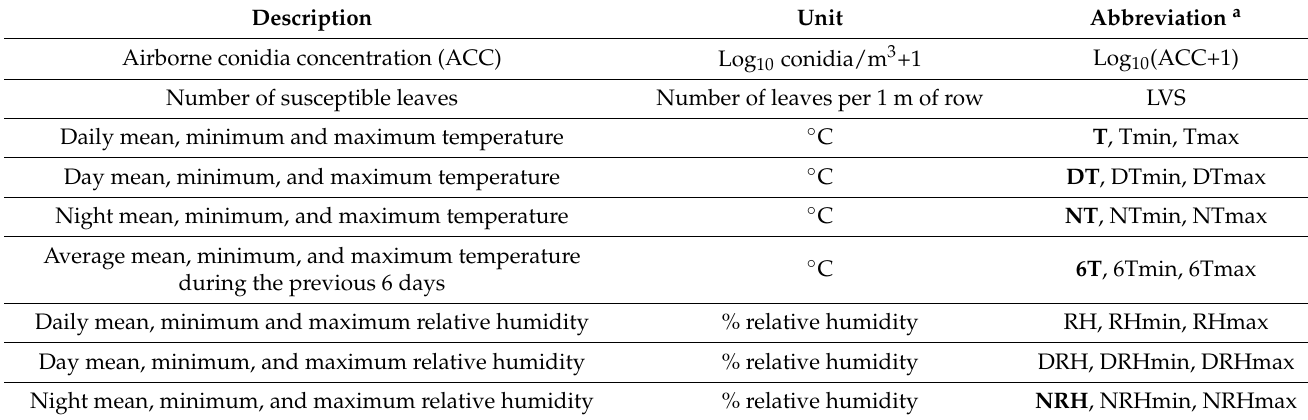
Table 1. Description of the inoculum, host, and weather